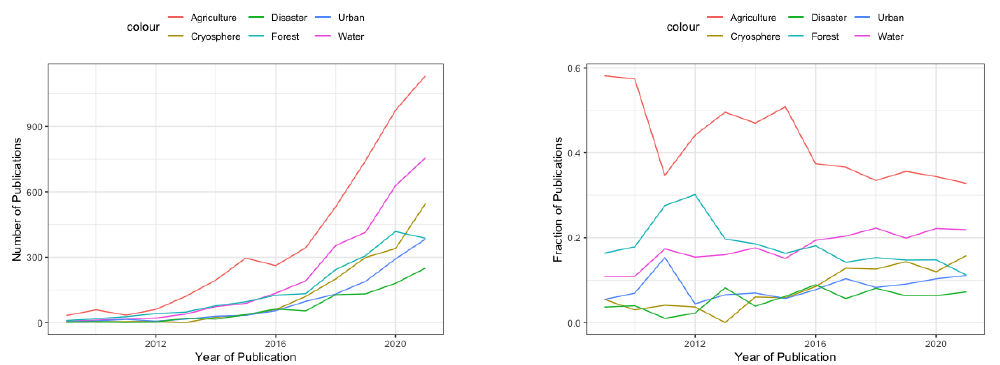
Figure 6. Number of articles published in Remote Sensing for a given application ( left ) and fraction of articles published in Remote Sensing for a given application ( right ).